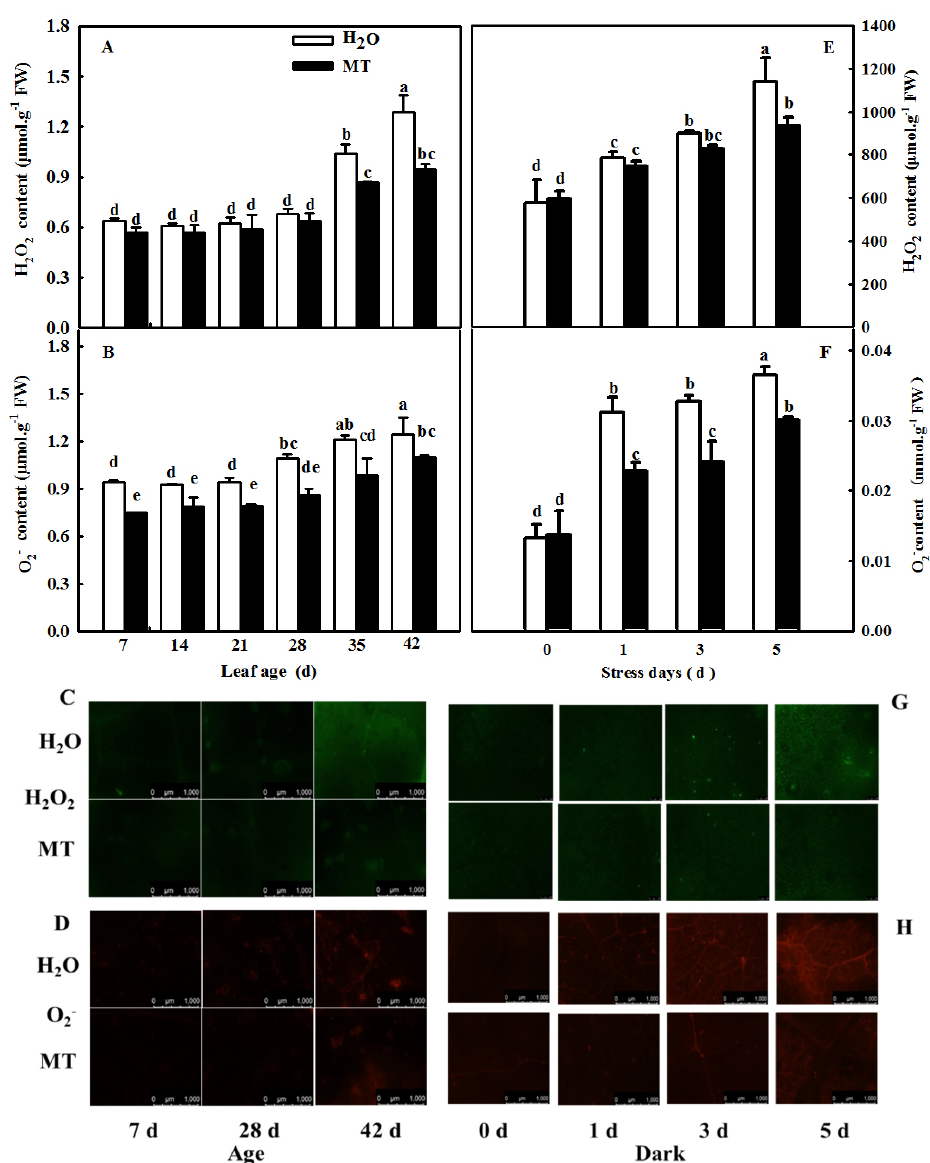
induced by age or darkness.